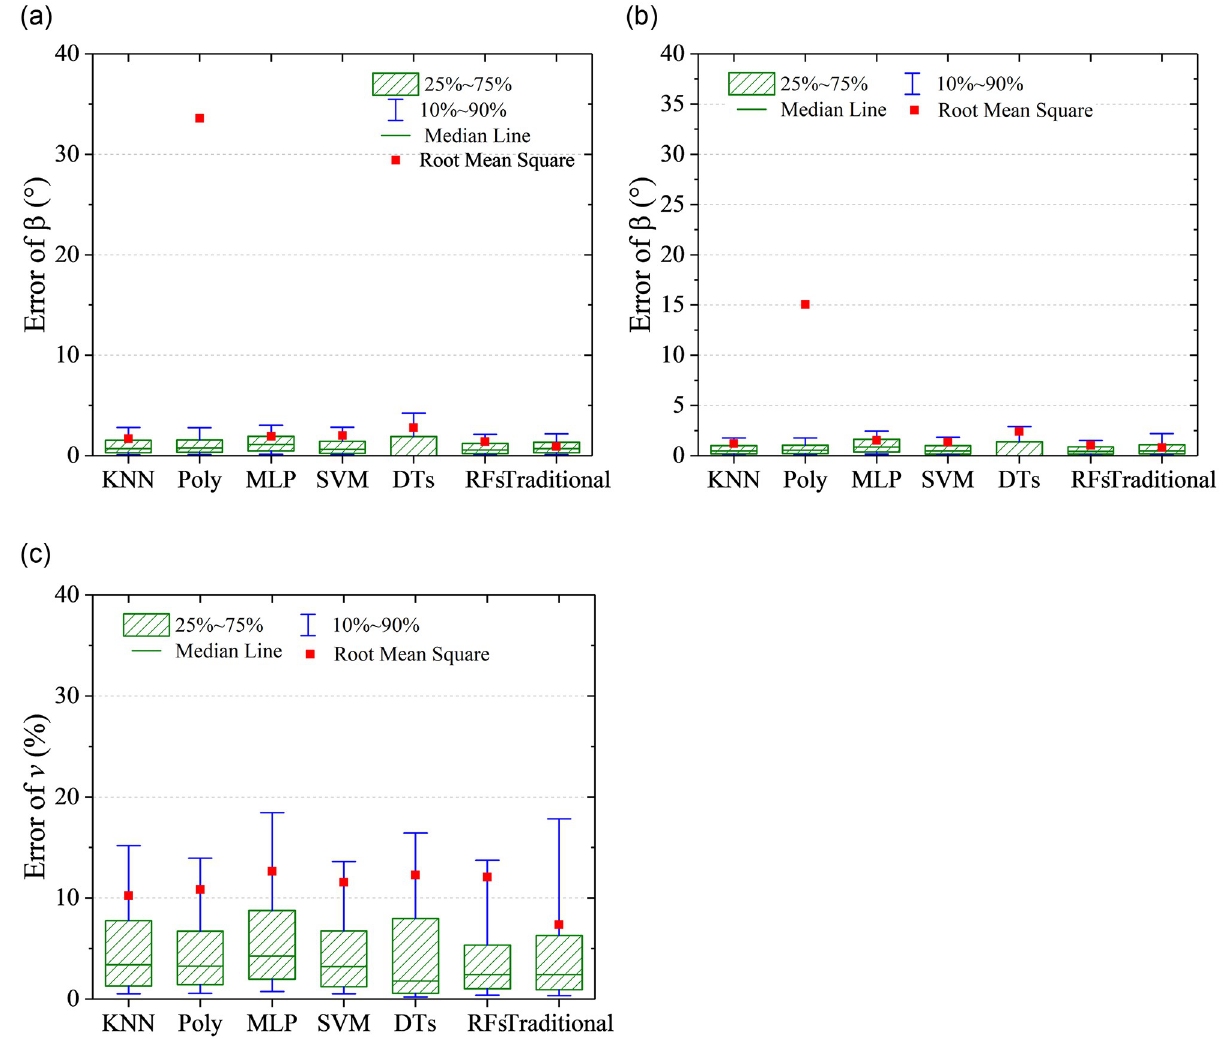
Fig 26. Quantile statistics on the prediction errors when port 7 is invalid. (a) angle of attack, α , (b) sideslip angle, β , (c) flow velocity, v